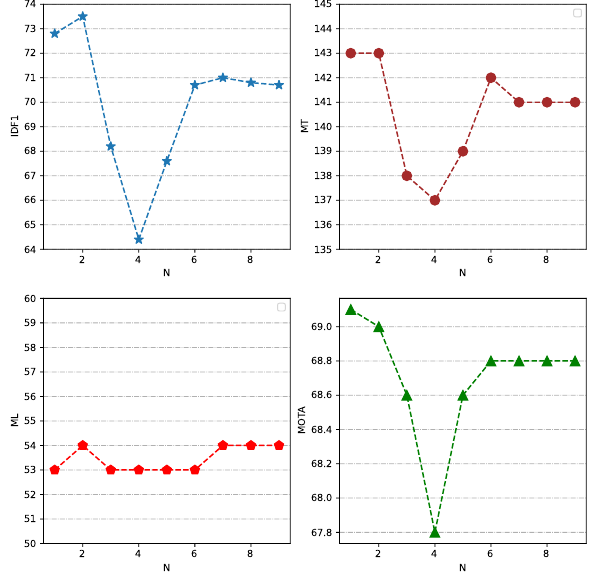
Figure 4. The change of IDF1, MT, ML, and MOTA indicators as N